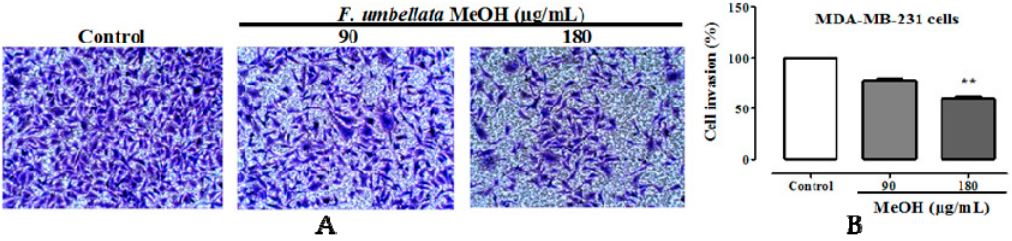
Figure 4. Effect of F. umbellata MeOH extract on cell migration potential. Microphotographs of one assay ( A ); and graphic representation of three independent wound-healing assay ( B ) in MDA-MB-231 cells migration after 24 and 48 h of treatment. ** p < 0.01, *** p < 0.001 as compared with control.